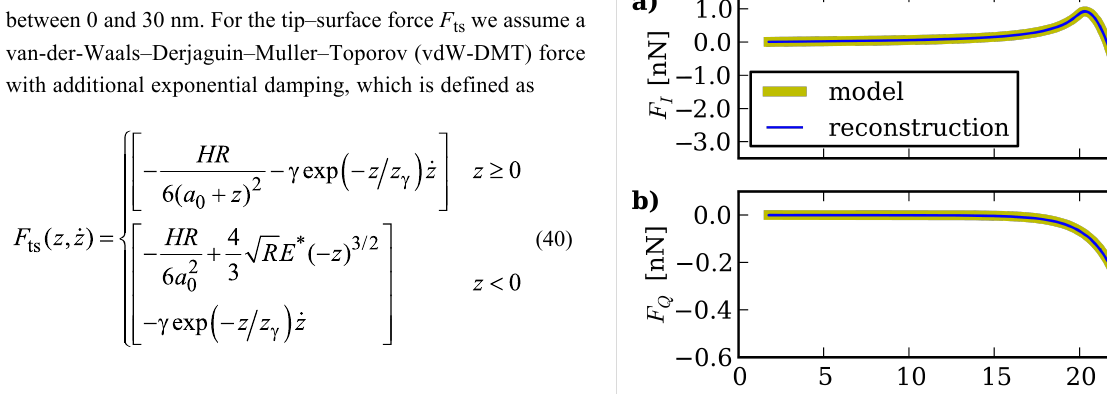
F Q as functions of the static probe height h only, and only one oscillation amplitude A was considered at each probe height. F I and F Q are, however, functions of both h and A as seen in the two-dimensional color maps shown in Figure 6 for the vdW- DMT force with exponential damping used in the previous section. In order to emphasize the interaction region near the point of contact, data in the h – A plane with F I < − 8 nN are masked with